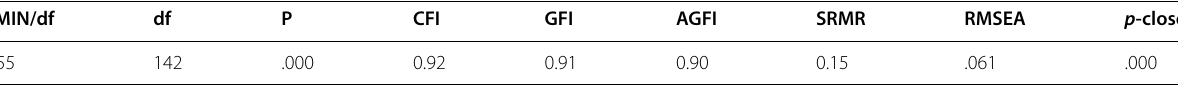
N 512 = CI Confidence